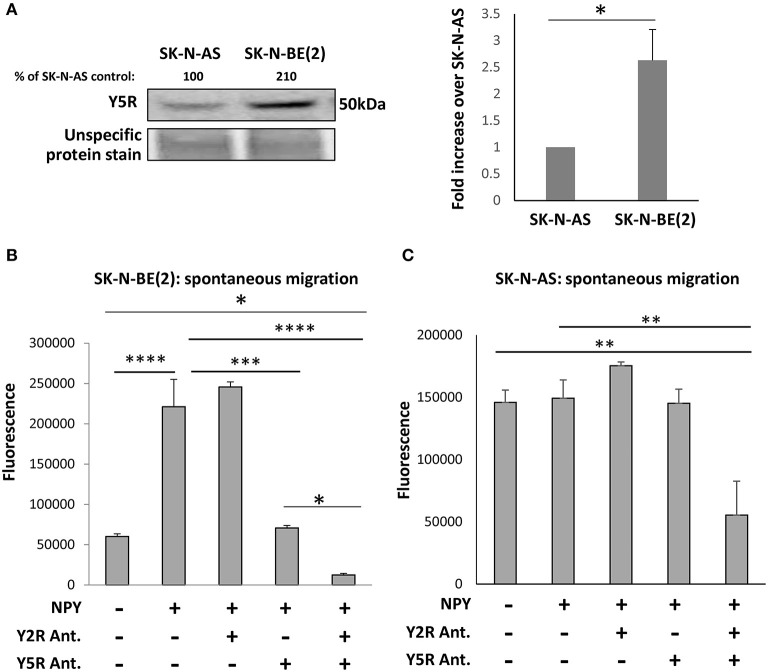
The NPY/Y5R axis promotes migration in NB cells. (A) Western blot analysis of Y5R expression in SK-N-AS and SK-N-BE(2) NB cell lines. *p < 0.05 by paired t-test, mean ± SEM, n = 4. (B) Spontaneous migration of SK-N-BE(2) cells treated for 22 h with NPY (10−7 M), in the presence or absence of Y2R antagonist (BIIE0246) and Y5R antagonist (CGP71683), each at a concentration of 10−6 M. (C) SK-N-AS cell migration in response to NPY (10−7 M), with or without Y2R and Y5R antagonists (10−6 M). (B,C) Spontaneous migration measured by a Transwell assay with NPY in both upper and lower chambers. *p < 0.05; **p < 0.01; ***p < 0.001; ****p < 0.0001 by one-way ANOVA followed by Tukey's test; mean ± SEM from two independent experiments, n = 4 each.